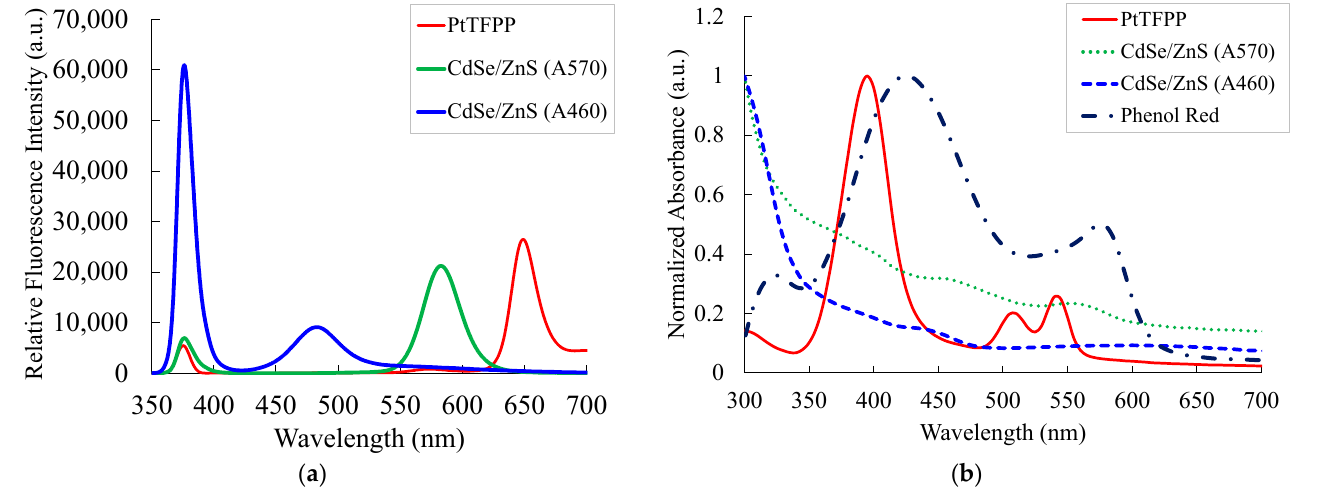
Figure 3. ( a ) Emission and ( b ) absorption spectra of PtTFPP, CdSe/ZnS (A570), and (A460) QDs.